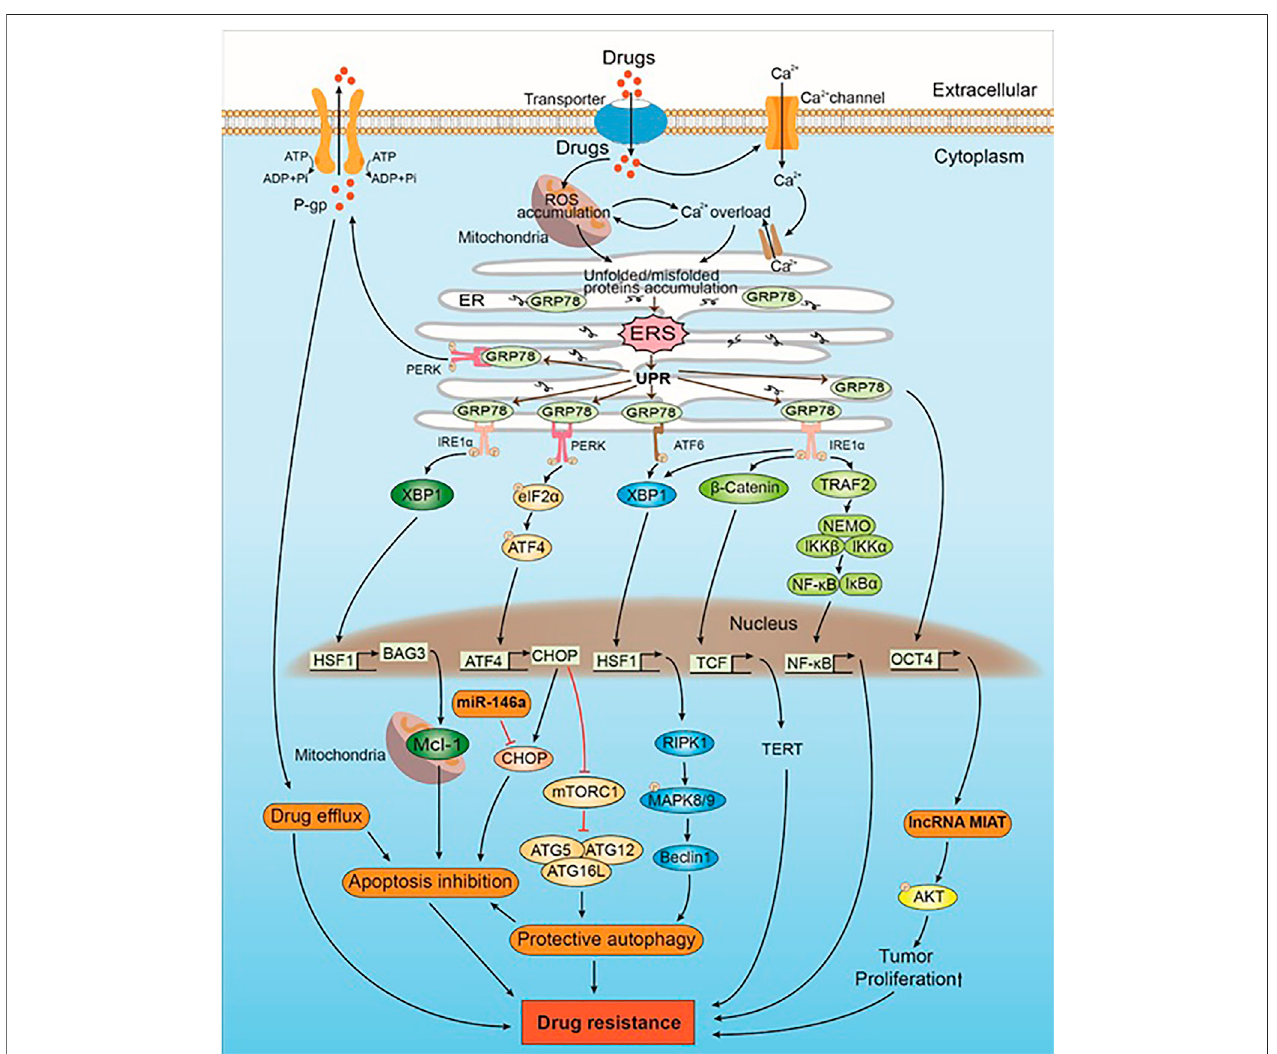
FIGURE1| Themechanismofdrug-inducedERScauseddrugresistanceinintrinsicdirection.DrugsinduceERSbyROSaccumulationandCa 2+ overload.UPRis activated when ERS occurs. GRP78, which originally binds to the UPR sensors (i.e., PERK, IRE1 α , and ATF6), inhibits their activation. GRP78 can upregulate the expression of lncRNA MIAT and Akt by positively regulating the expression of OCT4. AKT phosphorylation leads to drug resistance by promoting the proliferation of tumor cells. PERK trans-autophosphorylates after the dissociation of GRP78 and phosphorylates downstream eIF2 α , which in turn activates CHOP by regulating the expression of ATF4. CHOP promotes protective autophagy, which leads to drug resistance by inhibiting mTORC1 and promoting the expression of the ATG5 – ATG12 – ATG16Lcomplex.CHOP isalsoamediator ofapoptosis. miR-146a induces drugresistance byinhibiting CHOP-mediated apoptosis. Someintracellular drugs are pumped out of the tumor cells by P-gp that is increased by PERK, which in turn reduced drug-induced solid tumor cell apoptosis and led to drug resistance. IRE1 α is activated after dissociating from GRP78, and the downstream XBP1 upregulates the expression of HSF1. HSF1 upregulates the expression of BAG3, which stabilizes the expression of antiapoptotic protein Mcl-1, thereby inhibiting apoptosis and leading to drug resistance. In addition, both IRE1 α and ATF6 promote